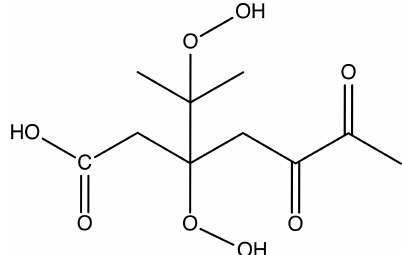
Figure 1. Molecular structure of the model C 10 H 16 O 8 HOM used in this